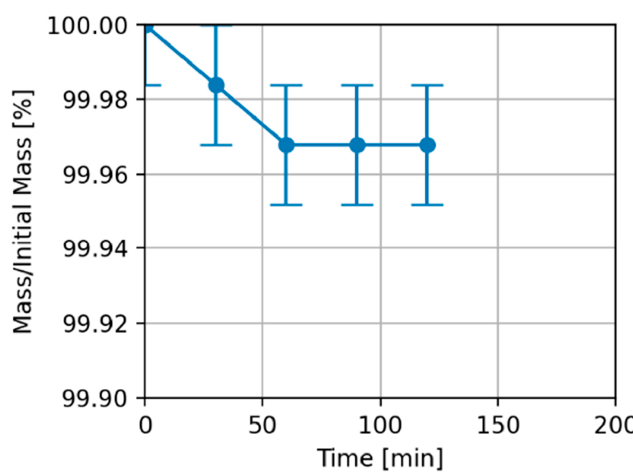
Figure 25. A 1 kg spool of PLA filament was dried in the vacuum oven. The change in mass was around 0.4 g, compared to the initial mass of 1245.7 g.